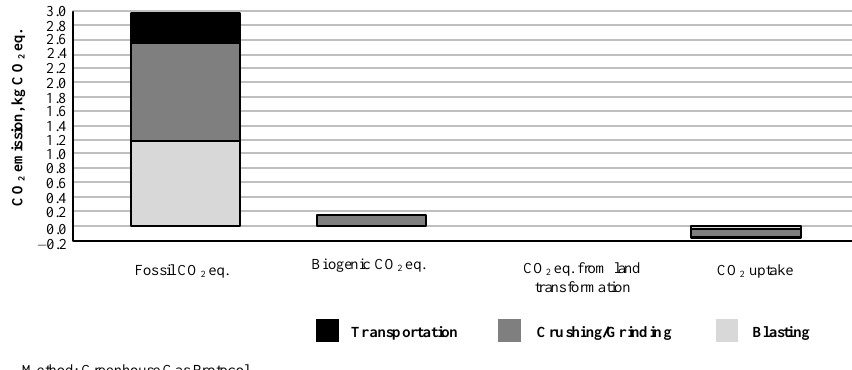
Fig. 8. Climate change impacts of limestone quarrying operation based on LCIA: Greenhouse Gas Protocol (kg CO 2 eq.). From the above impact assessments, it can be seen that energy used in the processes was the most significant environmental and climate change impacts in the limestone production. In the literature, some of the potential technologies and options to lower both energy and GHGs emissions from the mining sector are given below. However, it should be noted that feasibility of each mitigation option will mainly depend on the individual factory